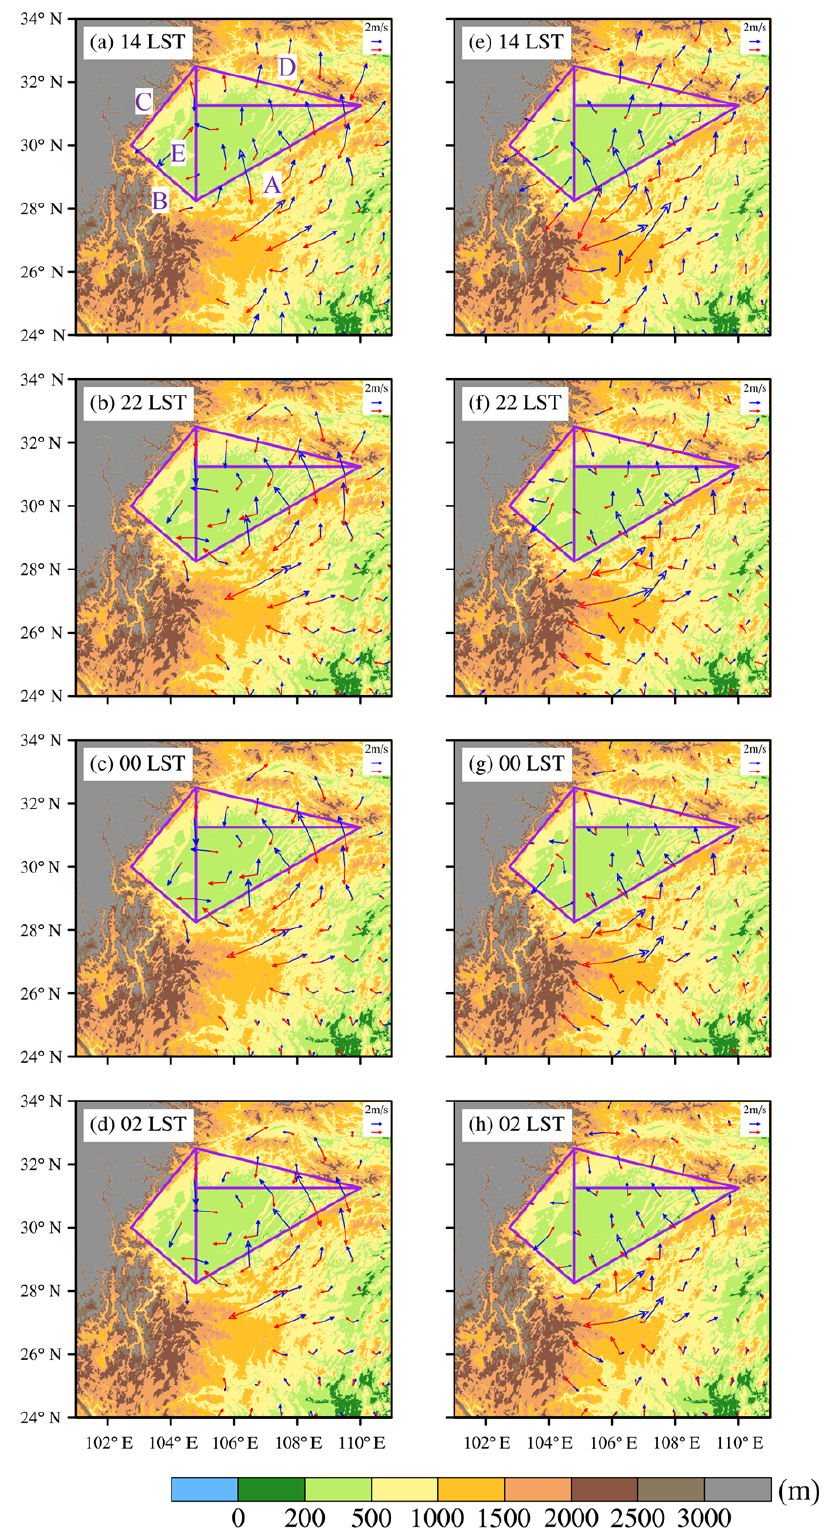
Figure 9. Diurnal variations of geostrophic creeping flows (blue arrows) and ageostrophic creeping flows (red arrows). ( a – d ) 900 hPa, ( e – h ) 850 hPa. Purple lines in ( a ) represent boundaries A, B, C, D, and E.